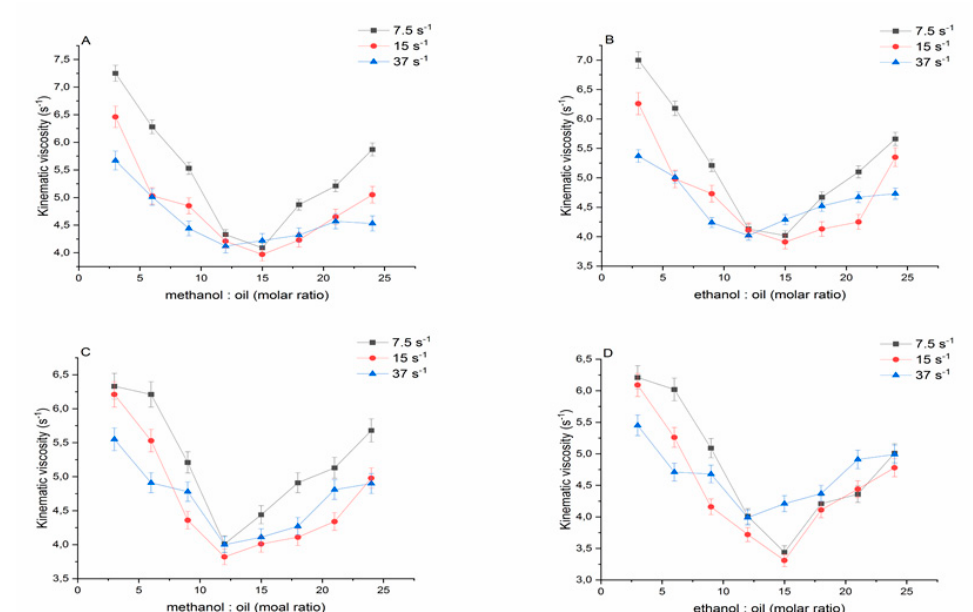
Figure 3. Kinematic -viscosity (40 °C, mm 2 /s 2 ) of rapeseed biodiesel obtained using methanol ( A ) and ethanol ( B ), and sunflower biodiesel obtained using methanol ( C ) and ethanol ( D ) at a different alcohol to oil molar ratio. Data are reported as the average ± SD (n = 3).